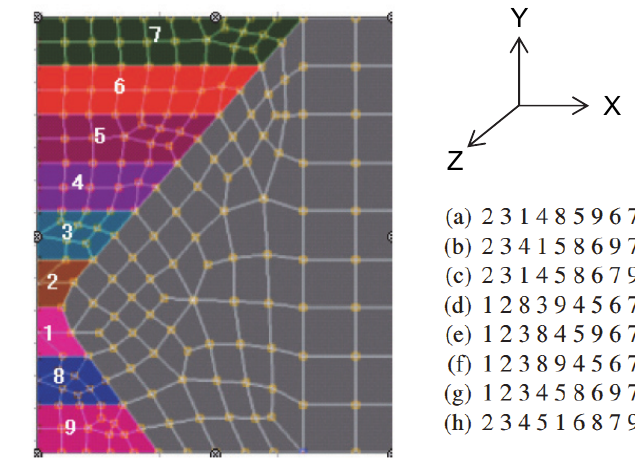
Figure 7: Illustration of welding bead numbers and sequences [12].